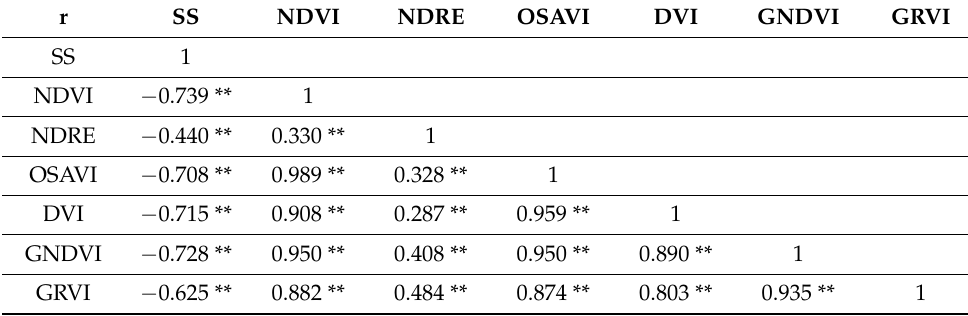
Table 3. Correlation coefficient between vegetation index and soil salinity.